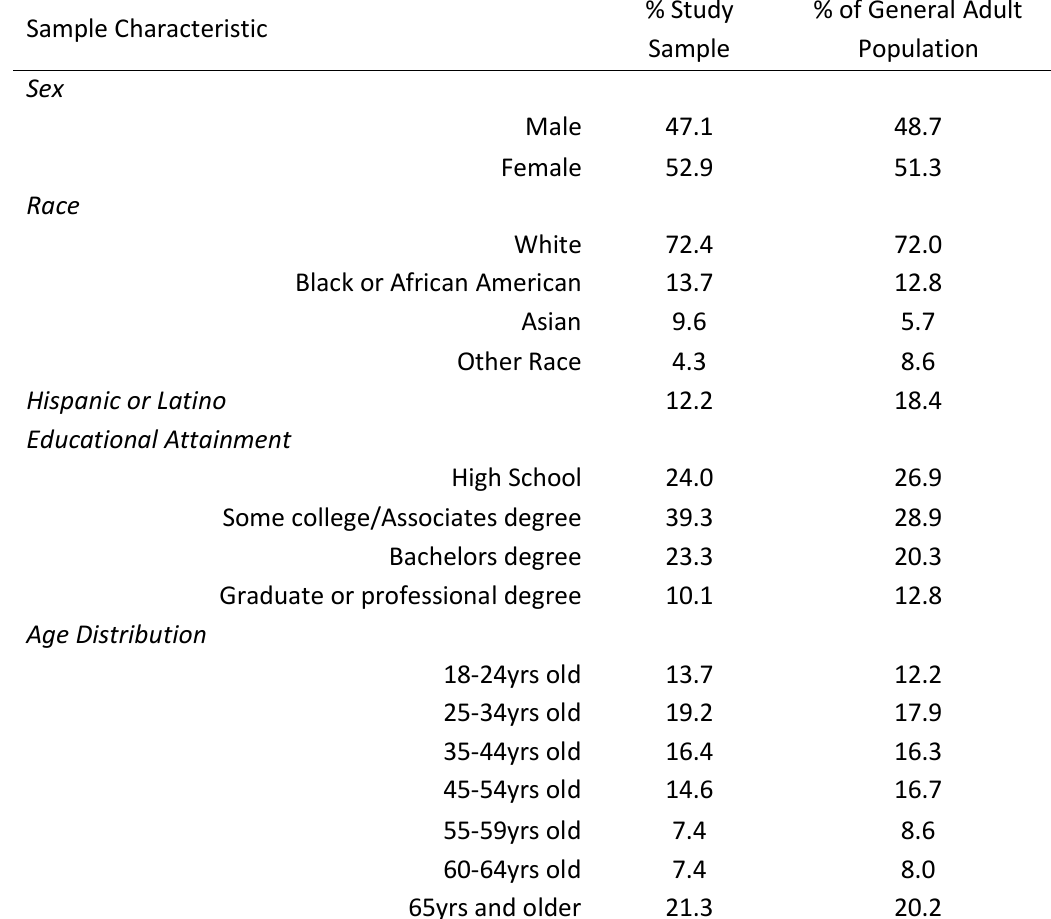
Table A5. Comparison of selected sample characteristics to US general